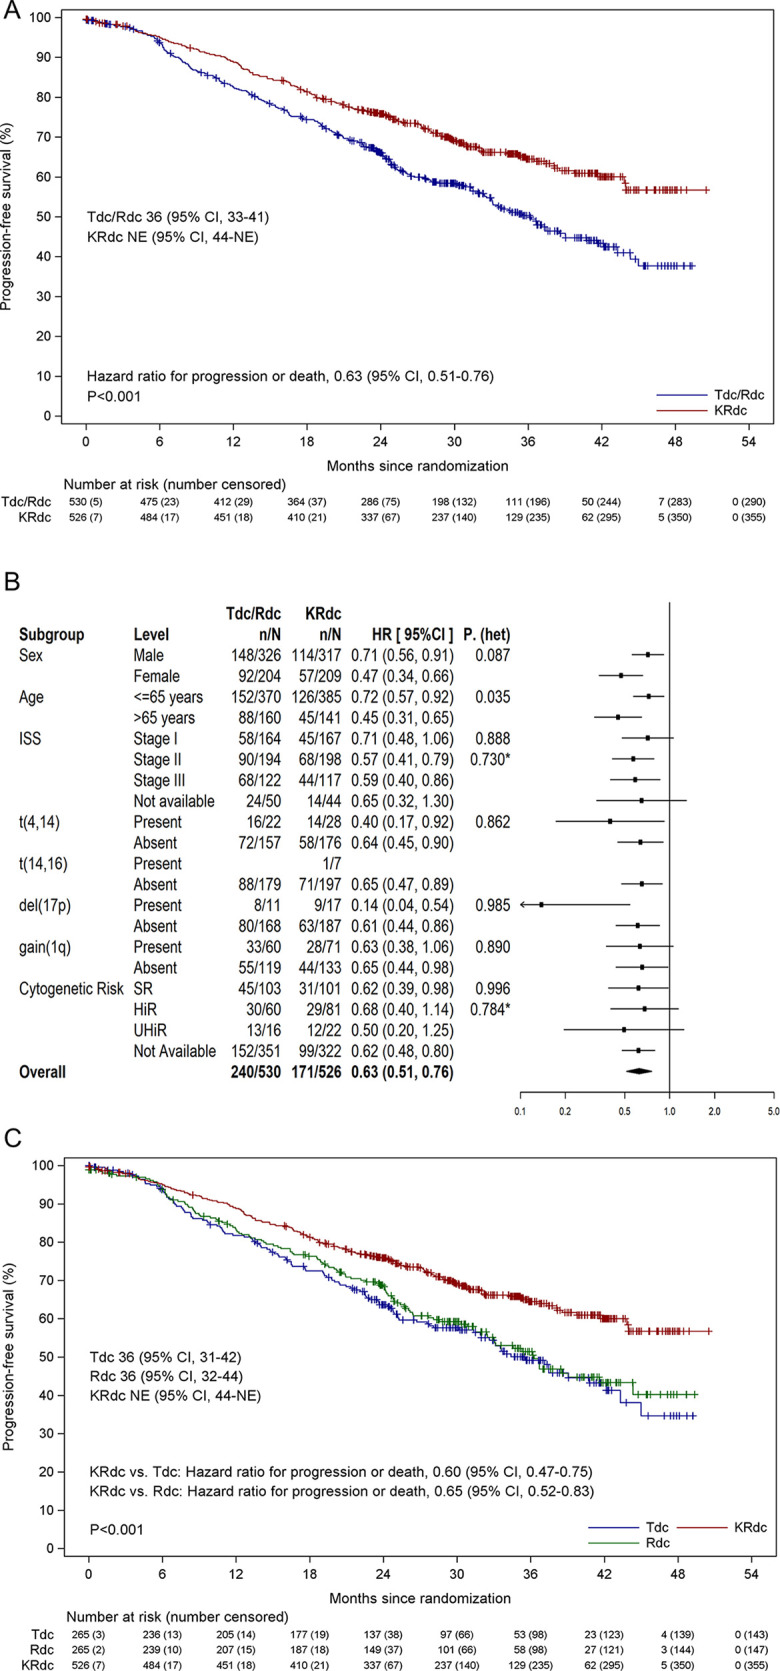
Progression-free survival.(A) Progression-free survival for KRdc compared to the Tdc/Rdc control group. (B) Subgroup analysis of progression-free survival with KRdc compared to the Tdc/Rdc control group. *Performed only for patients with subgroup data available. (C) Progression-free survival for KRdc compared to the Tdc and Rdc groups separately. HiR, high risk; ISS, International Staging System; KRdc, carfilzomib, lenalidomide, dexamethasone, and cyclophosphamide; NE, not estimable; P. (het), p-value from likelihood ratio test for heterogeneity of effect; Rdc, lenalidomide, dexamethasone, and cyclophosphamide; SR, standard risk; Tdc, thalidomide, dexamethasone, and cyclophosphamide; UHiR, ultra-high risk.